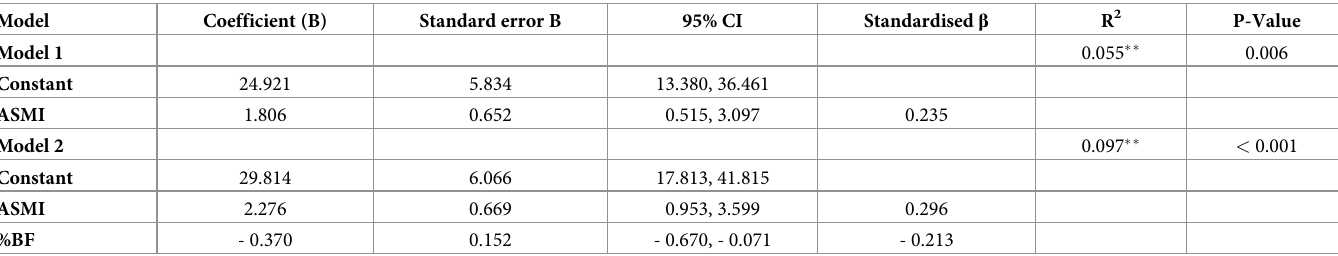
Table 3. Results of multiple linear regression modelling on the relationship between muscle strength, mass and body fat percentage in older males.